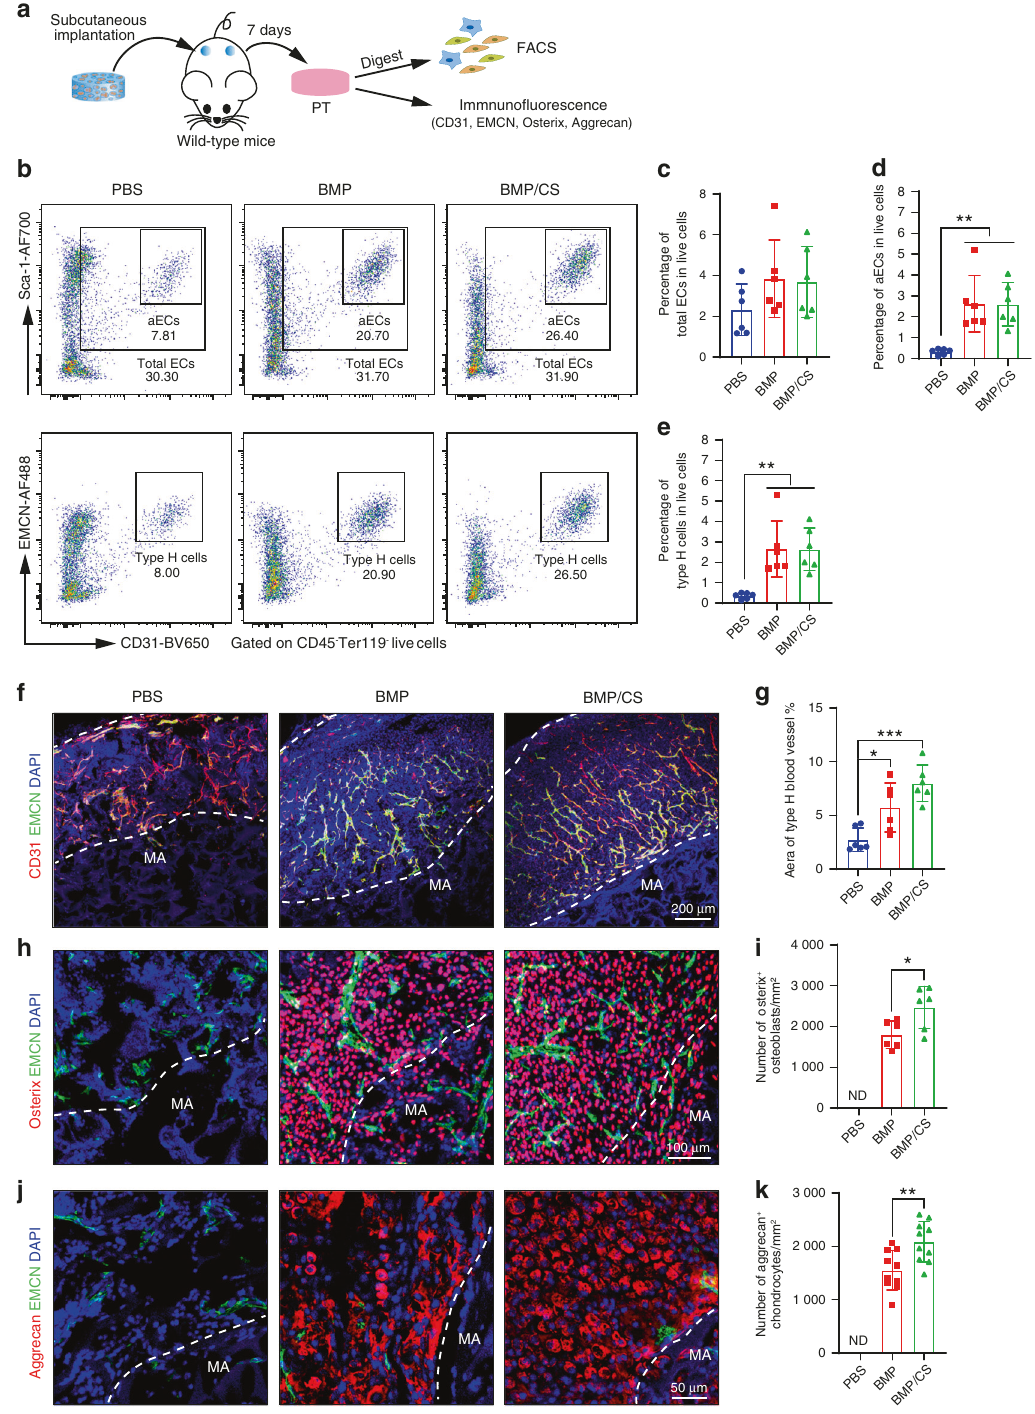
Fig. 4 Evaluation of functional blood vessels and osteochondral progenitor cells in PTs. a Scheme of the experiments for evaluating the abundance of blood vessels and osteochondral progenitor cells in PTs from the PBS, BMP, and BMP/CS groups. b Representative fl ow cytometric pro fi les of total endothelial cells (total ECs), arteriolar ECs (aECs) and type H cells of the PBS, BMP, and BMP/CS groups 1 week after subcutaneous implantation in wild-type mice ( n = 6). c – e Quantitative fl ow cytometric analysis of total ECs (Ter119 − CD45 − CD31 + Sca-1 + , c ), aECs (Ter119 - CD45 - CD31 hi Sca-1 hi , d ) and type H blood cells (Ter119 - CD45 - CD31 + EMCN + , e ) in the BMP and BMP/CS groups 1 week after subcutaneous implantation in young wild-type mice. Data are from individual animals and are shown as the mean ± SD. ** P < 0.01, one-way ANOVA followed by Tukey ’ s post hoc tests. f – k Immuno fl uorescence staining and quantitative analysis of type H blood vessels (EMCN + CD31 + , yellow; f , g ), Osterix + osteoprogenitors (red; h , i ), and Aggrecan + chondrocytes (red, j , k ) in the PBS, BMP, and BMP/CS groups 1 week after subcutaneous implantation in wild-type mice ( n = 6 – 8). CD31-positive cells, Osterix-positive cells, and Aggrecan-positive cells are red, EMCN-positive cells are green, and DAPI is blue (nucleus). Materials (MA). The white dashed line indicates the border of the material area and PT area. Data are from individual animals and are shown as the mean ± SD. * P < 0.05, ** P < 0.01, *** P < 0.001, one-way ANOVA followed by Tukey ’ s post hoc tests. Scale bar, 200 μ m ( f ), 100 μ m ( h ), and 50 μ m ( j